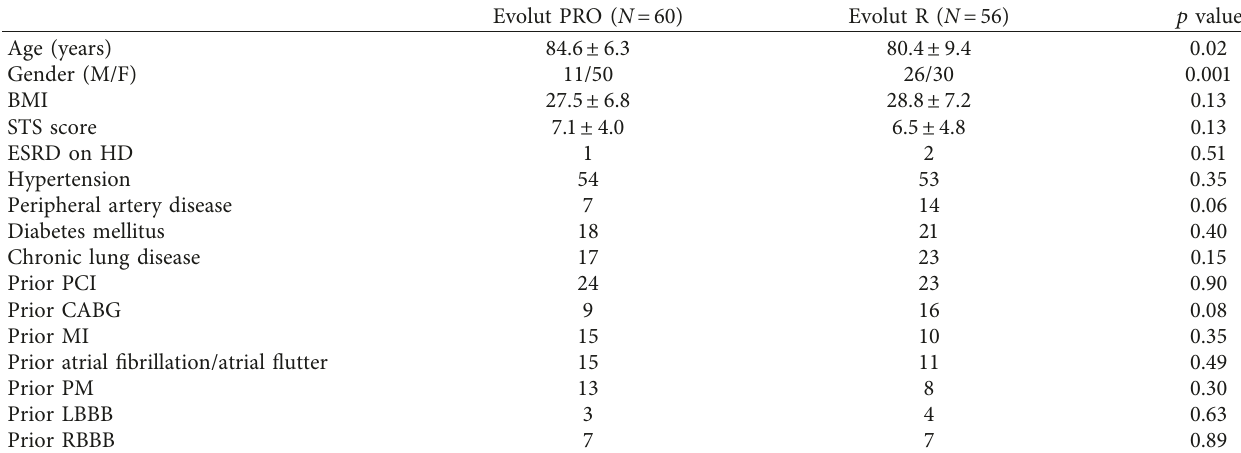
Table 1: Baseline characteristics.